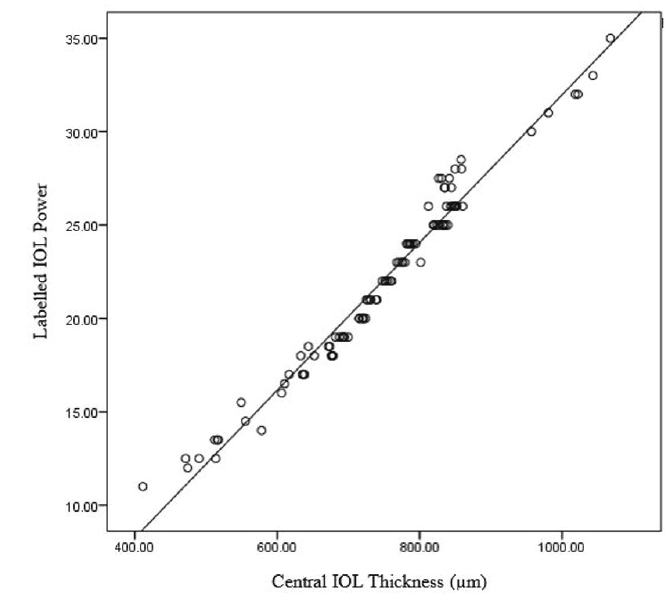
Figure 2. Plot of IOL thickness (microns) against labelled IOL power